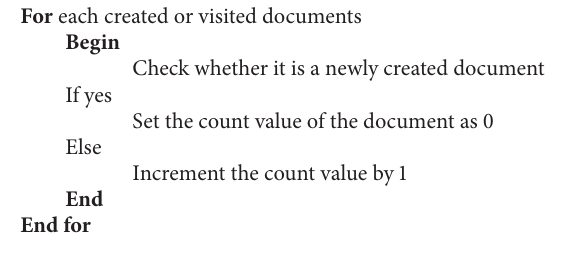
Algorithm 1: For counting the visiting time of the